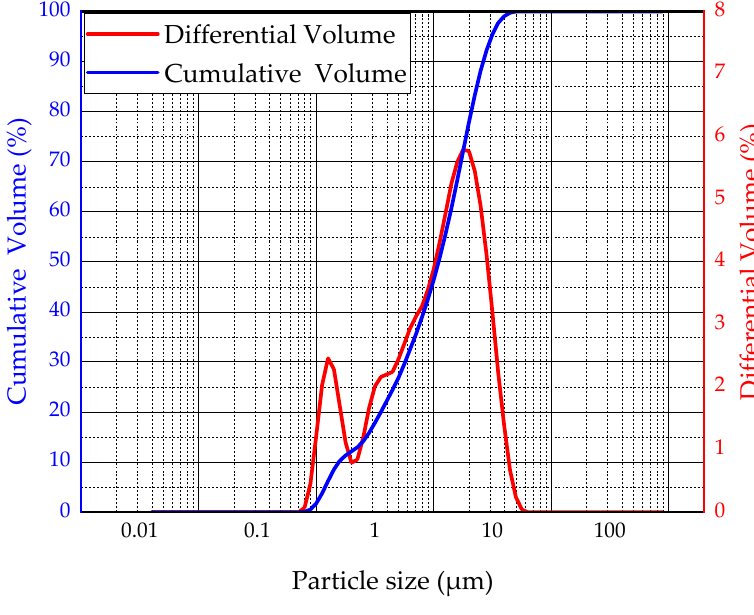
Figure 2. Particle size curve of slag.